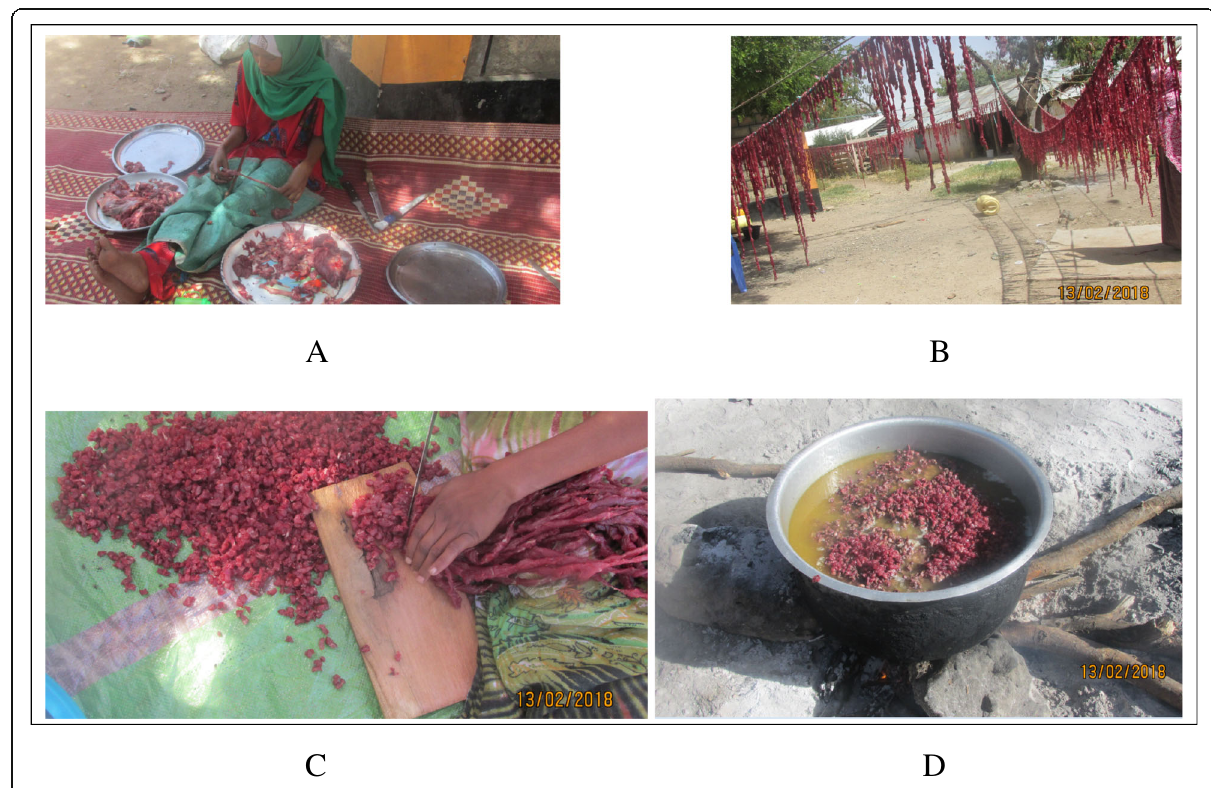
Fig. 3 Pictorial representation of traditional processing of koche product. a Size reduction (cutting meat strips). b Drip-drying of meat strips. c Size reduction (cutting of meat strips into cubes). d Deep-frying of meat cubes